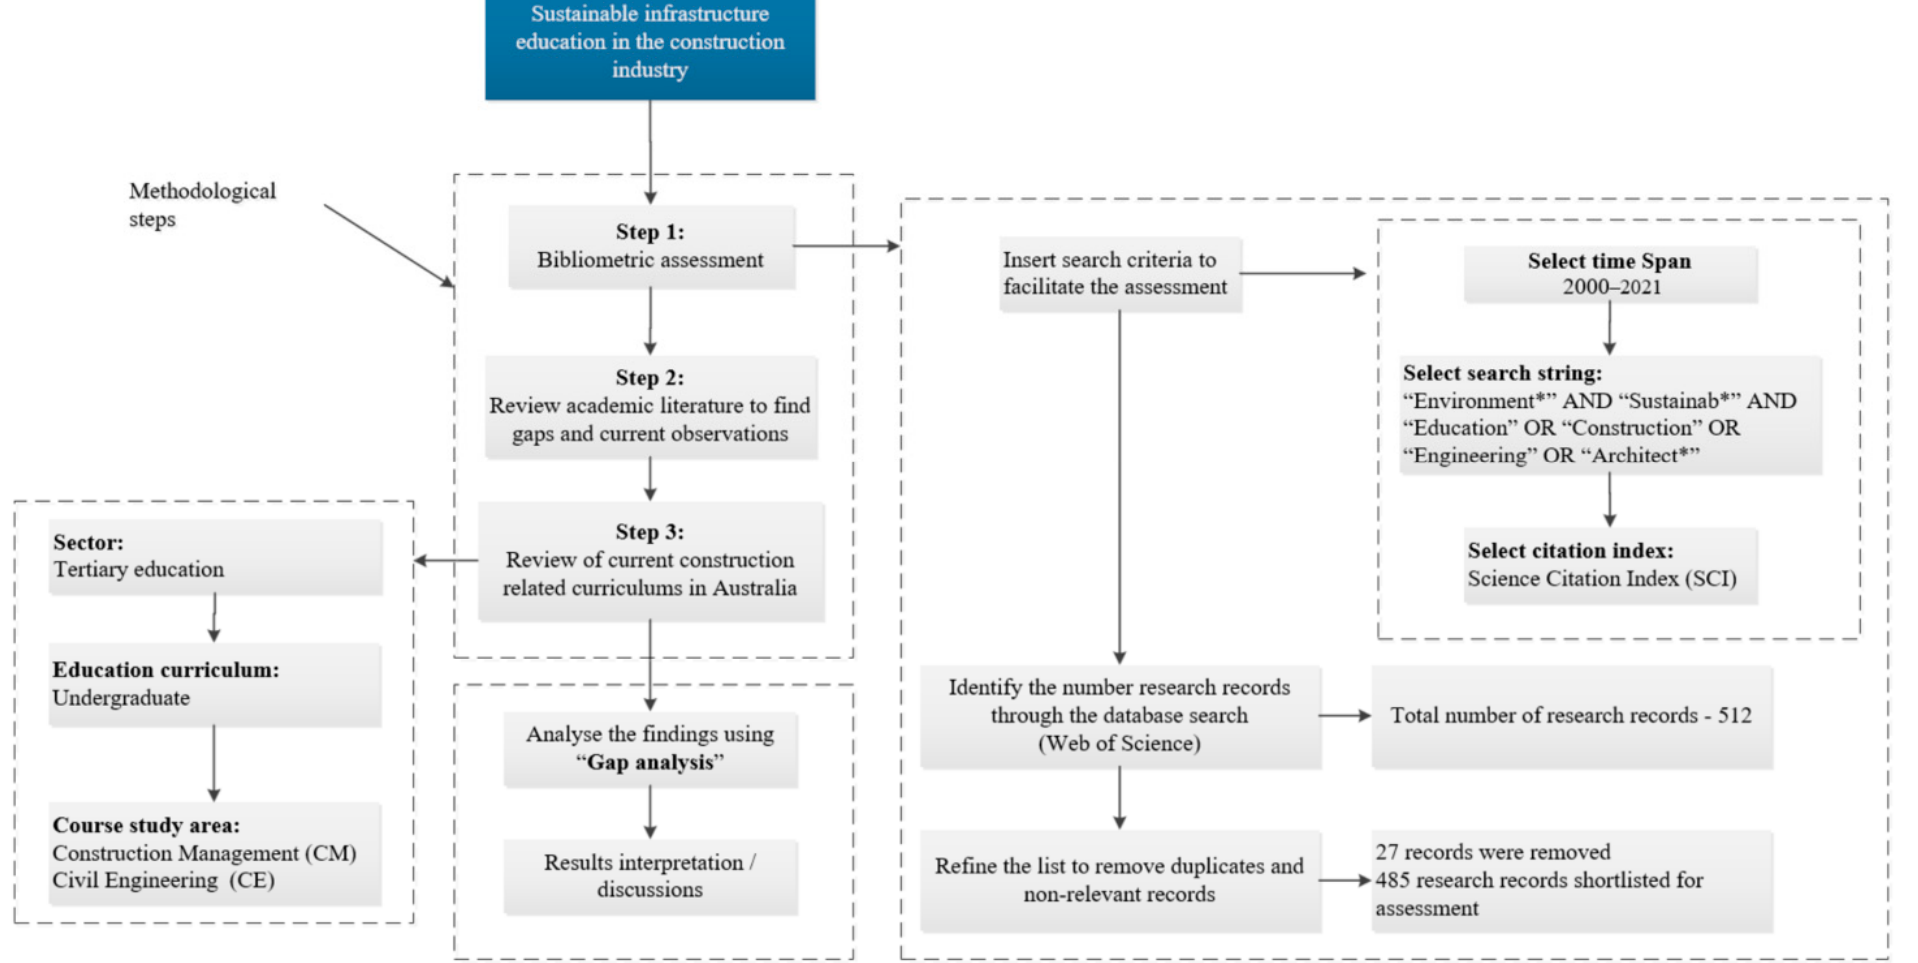
Figure 1. Research study scope and methodology .